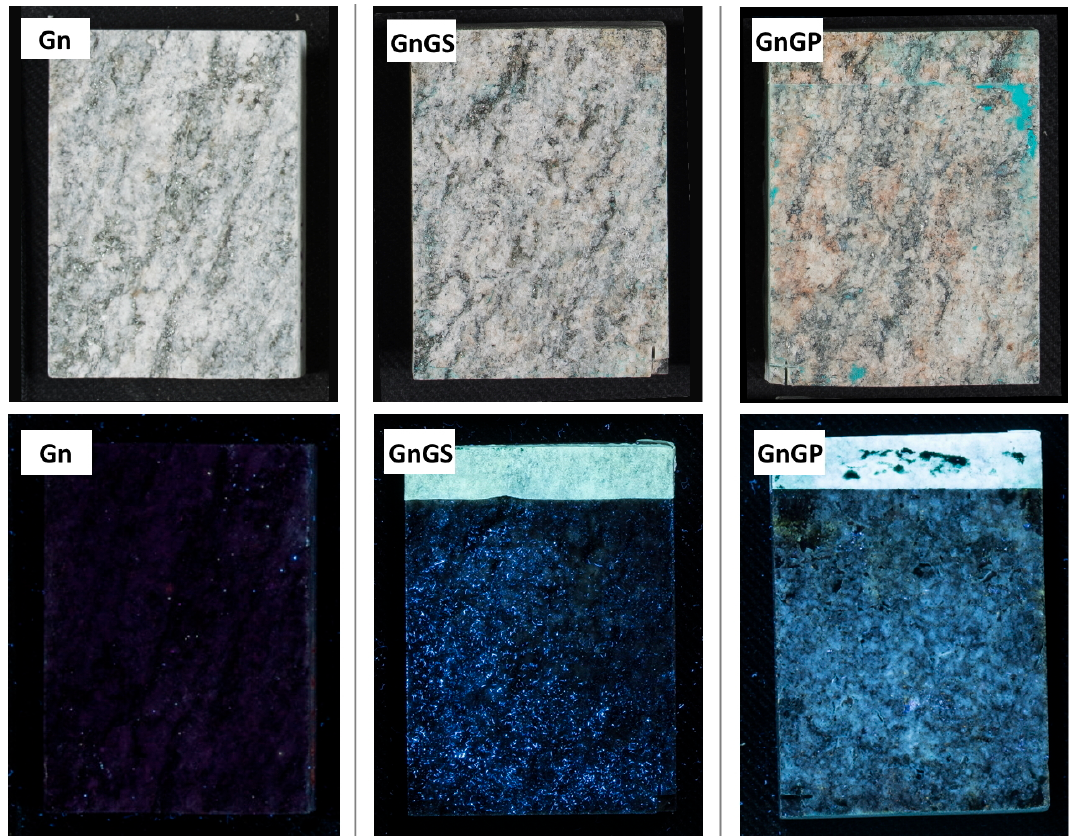
Figure 5. Digital and Ultraviolet (UV) photographs of the gneiss coated with the sacrificial and permanent anti-graffiti products after being cleaned with the products recommended by the manufacturers. Check Table 1 for sample